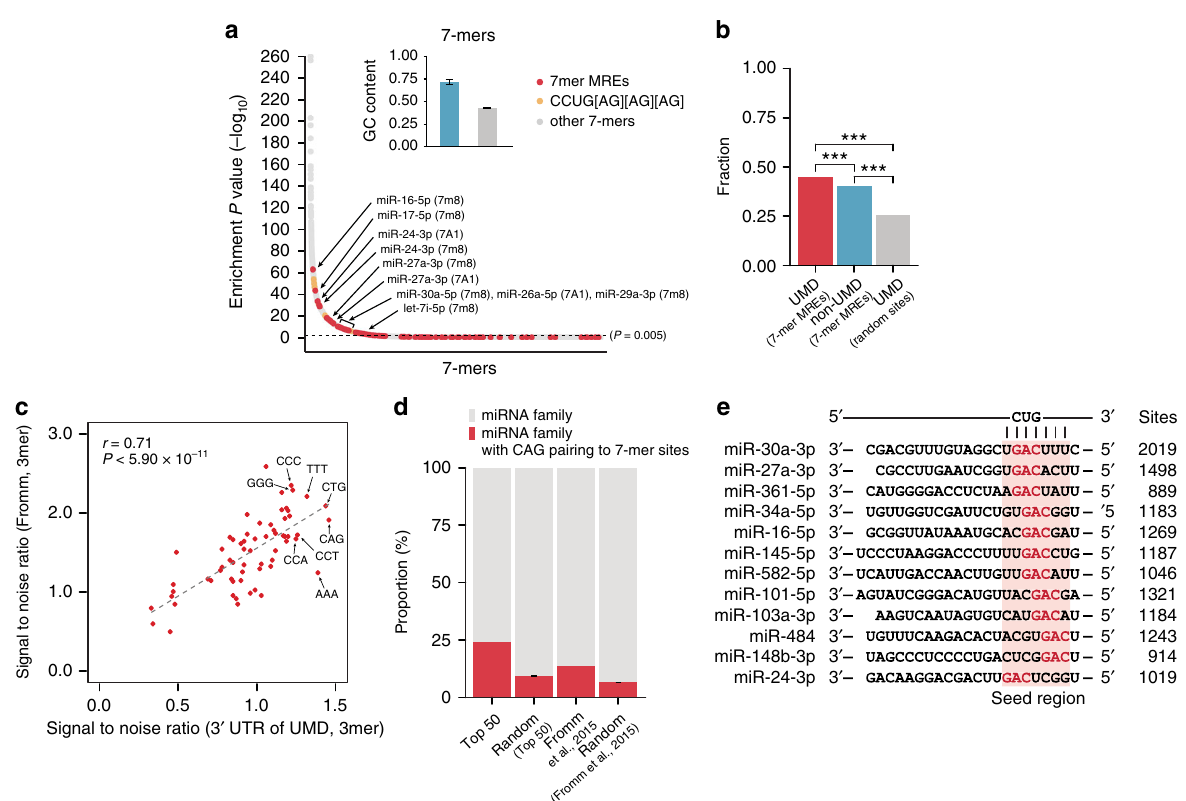
Fig. 2 Co-occurrence of the CUG motif and MREs in UMD targets. a Analysis of all possible 7-mers enriched in the 3 ′ UTR of UMD targets. 7-mer MREs of the 50 most abundant miRNA families (red dot), eight CCUG[AG][AG][AG] motifs (orange dot), and other 7-mers (gray dot) are shown with enrichment P values (nominal). The black dotted line is a threshold for signi fi cant enrichment (nominal P value < 0.005). The indicated 7-mer MREs are the sites of the 10 most abundant miRNA families. The site in the parentheses indicates the type of miRNA 7-mer sites. The inset bar graphs show the GC contents of other signi fi cant 7-mers (cyan box; more signi fi cant 7-mers than the 7-mer site for miR-16-5p) and less or nonsigni fi cant others (gray box; less signi fi cant 7-mers than the 7-mer site for miR-16-5p). The error bars indicate the standard errors of the mean (s.e.m.) of the GC contents. b The counts of CUG motifs within a ±5-nt window of a thousand 7-mer MREs in the 3 ′ UTRs of UMD targets (red) were compared to those within the ±5-nt window of a thousand 7- mer MREs in the 3 ′ UTRs of non-UMD targets (cyan) and those within the ±5-nt window of a thousand 7-mer random sites in the 3 ′ UTR of UMD targets (gray). Asterisks denote the statistical signi fi cance of the differences ( *** P < 2.20 × 10 − 16 ). c The signal-to-noise ratios of 3-mers from sequences reverse complementary to annotated human miRNAs ( x -axis) and from the 3 ′ UTR of UMD targets ( y -axis) are shown in an x – y plot. The dashed line is fi tted to the data with Pearson ’ s correlation coef fi cient ( r = 0.71). d The proportion of the 50 most abundant miRNA families (in HeLa) and their dinucleotide-shuf fl ed random sequences (100 cohorts) and all human miRNA families and their dinucleotide-shuf fl ed random sequences (100 cohorts) that embed CAG pairing to their 7-mer sites. The error bars indicate the s.e.m. of the proportions for random miRNAs. e Of the 50 most abundant miRNA families, 12 embedded CAG motifs in their seed regions (pink box). Sites are the number of miRNA 7-mer sites in the 3 ′ UTRs of UMD our RNA-seq data (Fig. 3a; P ≤ 0.014 for all three; one sample t